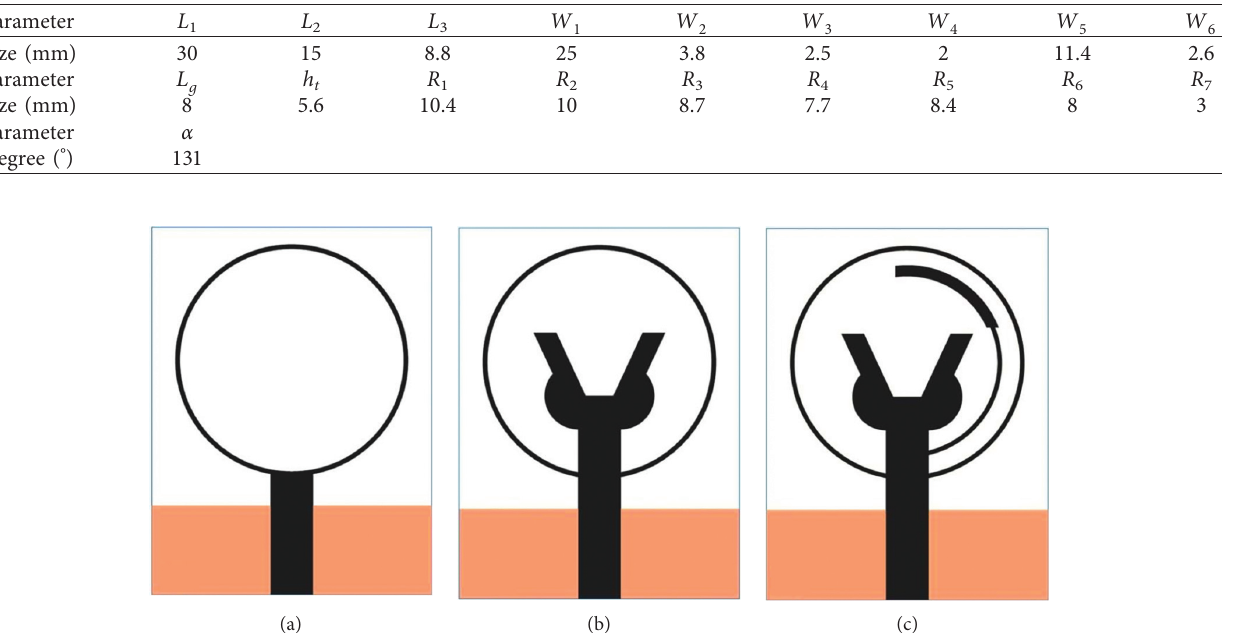
Figure 2: Design evolution of (a) antenna-1, (b) antenna-2, and (c)